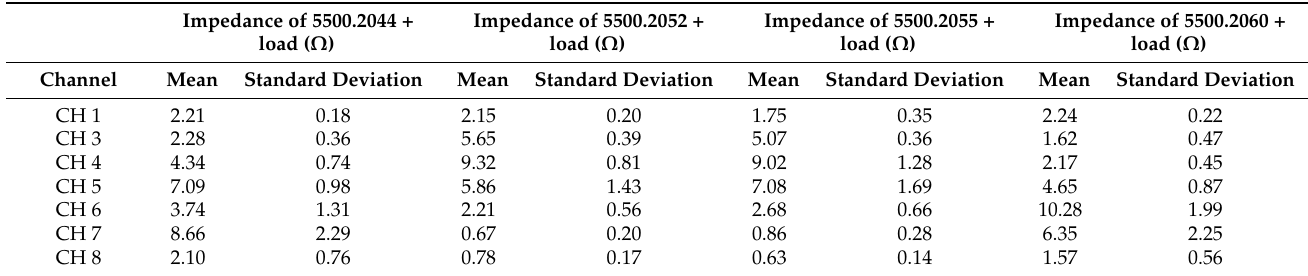
Table 4. Mean and standard deviation of the impedance measured when EMC filters are connected to the setup, connecting a load in L’-N’.